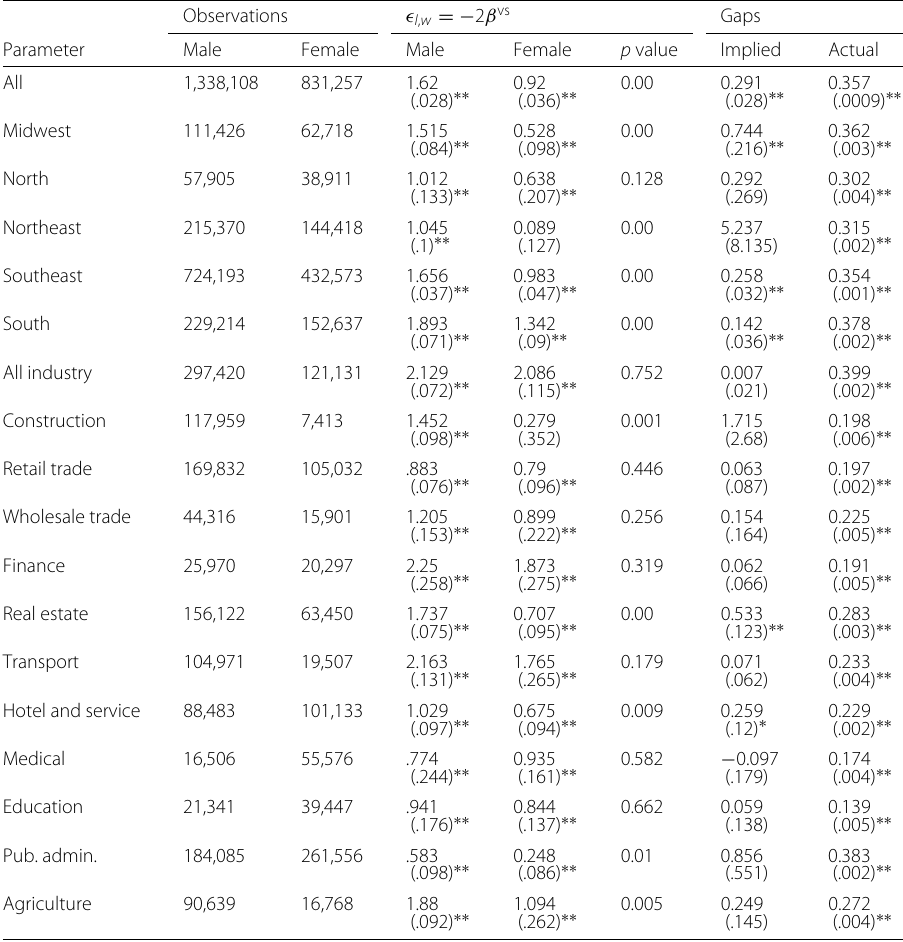
Table 4 Wage elasticity and implied and actual wage gaps, by region and sector Observations (cid:2) l , w = − 2 β vs Gaps Parameter Male Female